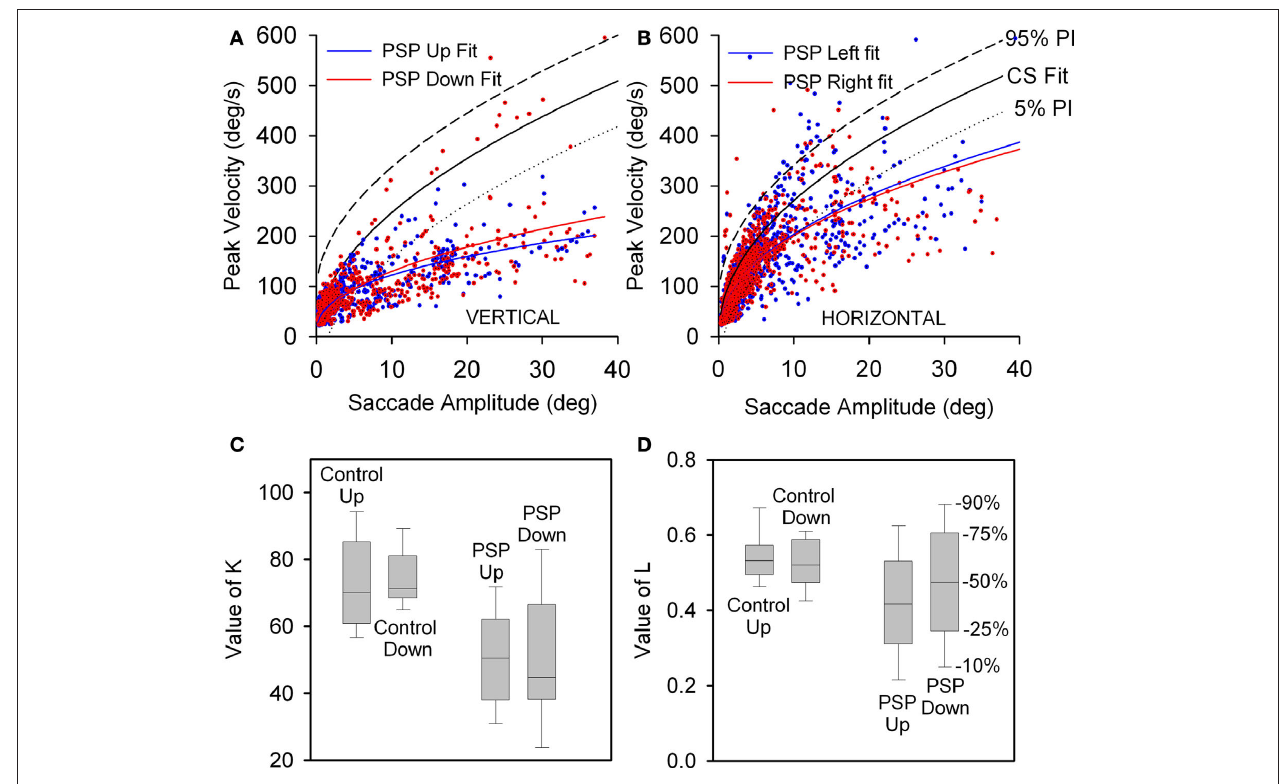
Figure 3 | Peak velocity–amplitude relationship of vertical saccades (A) and horizontal saccades (B) made by control subjects (CS) and PSP patients. (A) Upward and downward power fits calculated for all vertical saccades made by 17 PSP patients for whom R 2 > 0.7. Fit, 5 and 95% prediction interval (PI) for all CS saccades are shown. Most of the faster downward saccades were made by one patient with 1.5 year disease duration. (B) Horizontal saccades made by PSP patients were slower than those made by CS